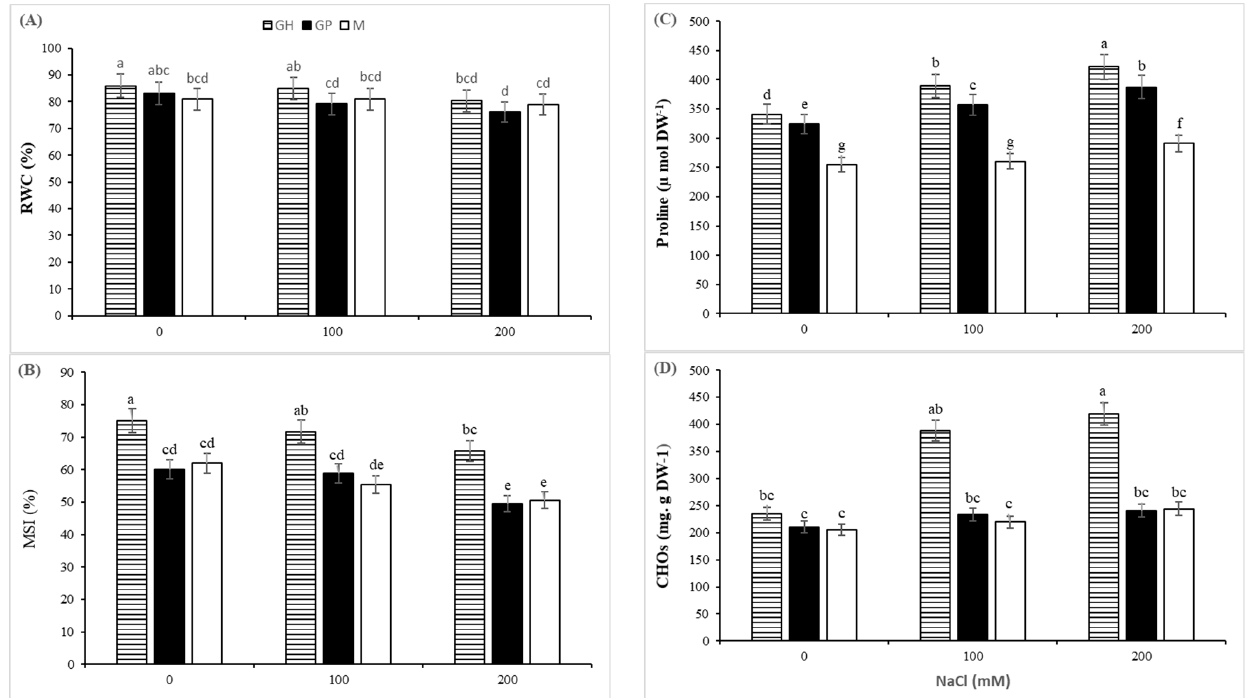
Figure 2. The effect of controlled salt treatment on RWC ( A ), MSI ( B ), and proline content ( C) and CHOs ( D )) of three pistachio rootstocks including GH (Ghazvini), GP (Ghermez-Pesteh) and M ( P. atlantica subsp. mutica ). Bars with different letters shows significant difference according to Tukey’s multiple range test ( p < 0.05).